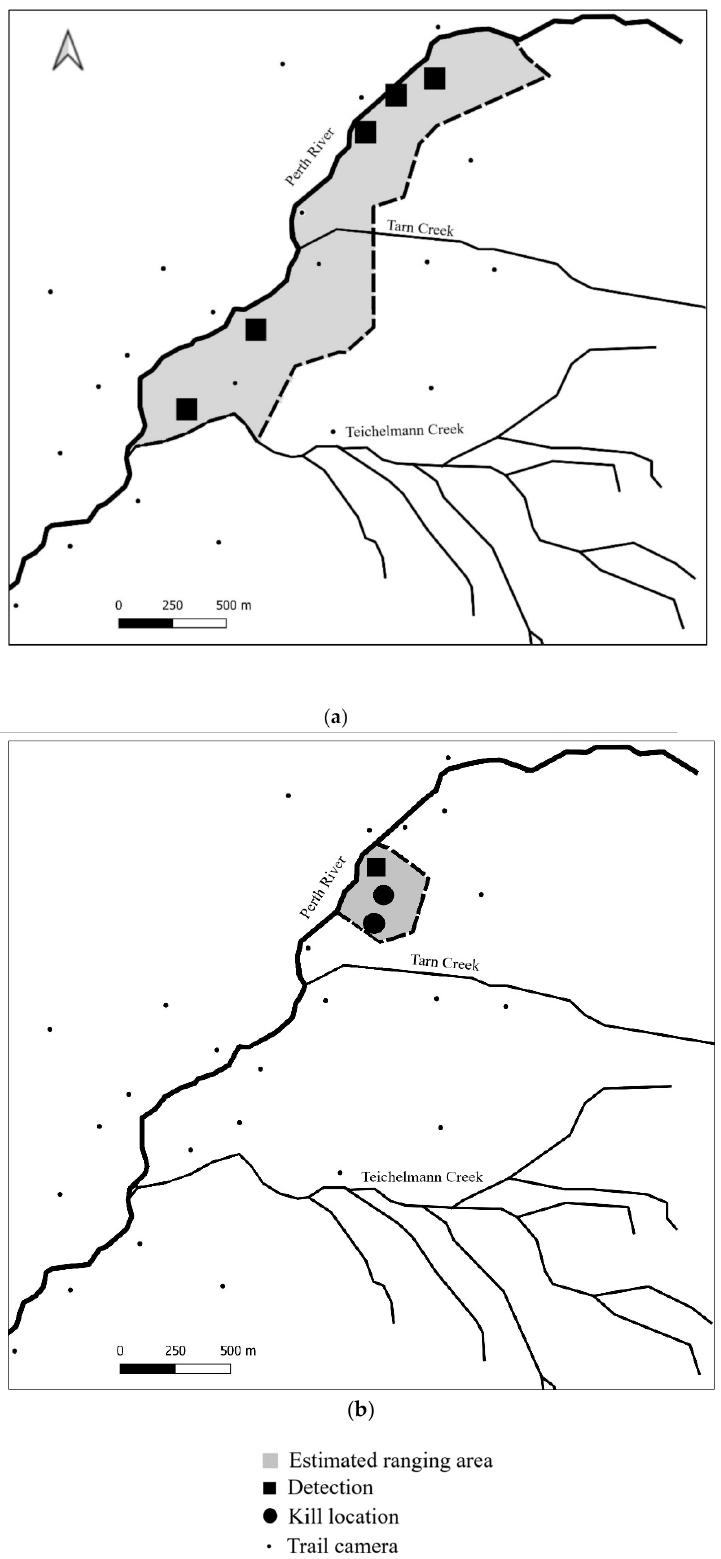
Figure 5. Detection, estimated home ranges and kill location for survivors in the Upper Perth Valley (area enlarged from Figure 4): ( a ) Detection locations 23 July 2019–14 April 2020; ( b ) detection and capture locations 15 April–29 June 2020. The number of detection locations differs from the number of detections stated during these periods, as camera sites were visited multiple times. In the first nine months of this period, between 23 July 2019 and 14 April 2020, ten detections were spread across the five cameras (Figure 5a). It was not possible to tell the two animals apart in all images, so we cannot rule out the possibility that both animals were ranging over the entire area between the detections. Detectability for this time period is calculated as 0.0023/TN with a 95% CI of (0.11, 0.42) for both animals in the combined area. A second possibility is that the activity area for each possum was separated by Tarn Creek (Figure 5). Detectability would then become 0.0046 with 95% small sample CI of (0.23, 0.84). Detectability is doubled as each possum is assumed to not have access to half of the cameras. The approximate range of the two animals was calculated as 93 ha, or approximately half of that each if occupying separate areas. The product of detectability and area will be unchanged [44]. The uncertainty in the area is large—we estimate ±50%. From 15 April 2020 up to and including captures, there were a further nine detections, all at a single camera (Figure 5b). Based on this and the two capture locations, we can assume that the possums were not separated by Tarn Creek. Over this time period, detectability increased to 0.026/TN, 95% C.I. (0.07, 0.44). 4. Discussion